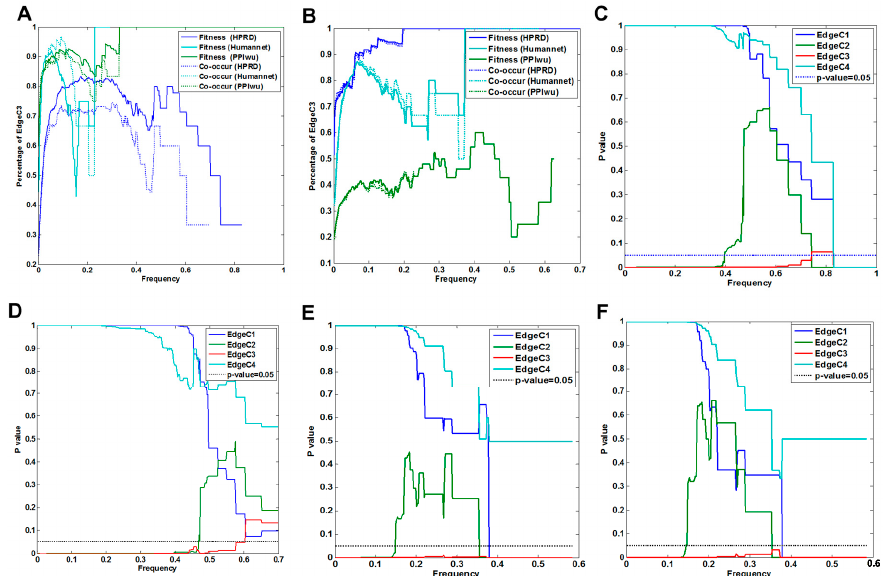
Figure 5. Statistics and significance of edges in each edge class. ( A , B ) Variations of fitness edges and co-occurring edges in EdgeC3 under frequency cutoffs in fitness networks in COAD and SKCM ( B ); ( C , D ) Significance of fitness edges in each edge class with frequency cutoffs in FN.hp for COAD ( C ) and SKCM ( D ); ( E , F ) Significance of co-occurring edges in each edge class with frequency cutoffs in FN.hp for COAD ( E ) and SKCM ( F ). Results show a consistent significance of fitness edges and co-occurring edges in EdgeC3 under different frequency cutoffs.